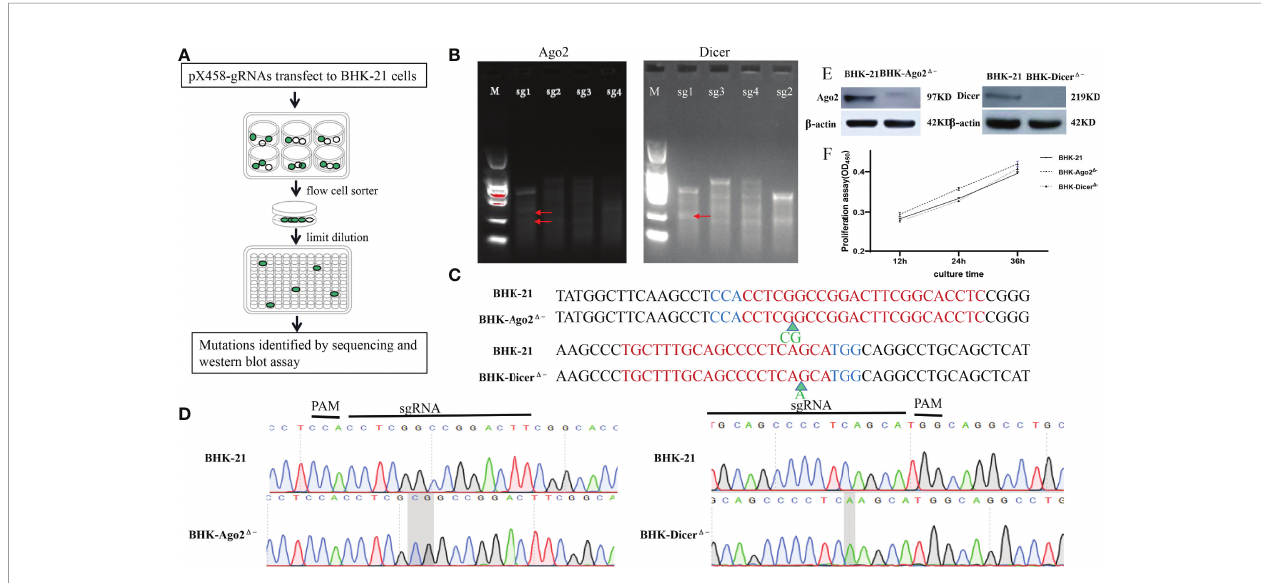
FIGURE 1 | Construction and identi fi cation of knockout celllines. (A) Schematic of the construction process ofknockout celllines. After transfection with the plasmids targeting Dicer andAgo2 protein genes into BHK-21 cells, cellsorting was performed by fl ow cytometry. After 1-2 days, stable celllines containing variousmutant cells and normalcells were obtained,with limiting dilutions by 96-well plates several times (dilutedas 10 cells/welleverytime),mutant cells were enriched. Mutationswere con fi rmedby sequence analysisand Westernblot assays. (B) T7EI assay was performed to detect the mutants. White arrows indicatethe predicted sizes of T7E1 digestion. Primersused or the PCR reactions are listed in Table 2 . The bands marked by the red arrows are the bands cut by the T7E1 enzyme. (C) Partial sequence alignment results of mutant Ago2 and Dicer near mutant sites in BHK-21 and knockout cell lines. Red color-marked nucleic acids indicate gRNA target sequences, while the blue ones indicate PAMs. Green arrows represent the inserted bases. (D) Sequencing peak diagram of mutant Ago2 and Dicer near mutation sites in BHK-21 cells and knockout cell lines. (E) Identi fi cation of Ago2 and Dicer protein. The Ago2 and Dicer protein could not be detected in the knockout cell lines, proving that Ago2 and Dicer genes were completely knocked out. (F) Knockout of Ago2 and Dicer genes did not signi fi cantly affect the cells ’ proliferation. The numbers in the y-axis represent fold changes derived from the OD values by measuring the absorbance at 450nm using a microplate reader. Data are expressed as the mean ± SEM from three independent